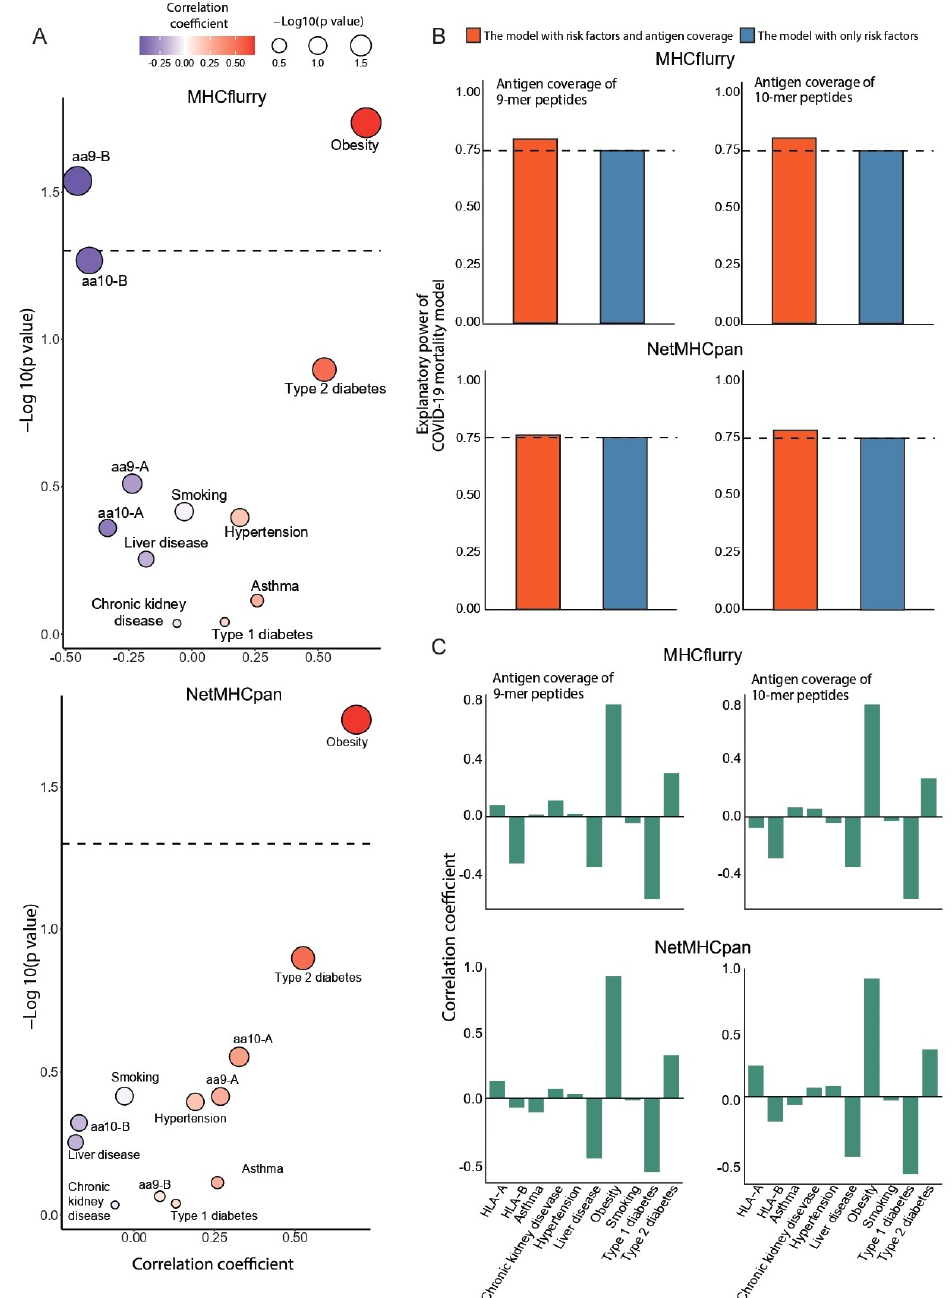
Figure 2. ( A ) Eight risk factors (asthma, chronic kidney disease, liver disease type 1 diabetes mellitus, type 2 diabetes mellitus, hypertension, obesity, smoking) and the antigen coverage of HLA-A and HLA-B were analyzed for their correlation with the death rate of COVID-19. The dot color and X -axis represent correlation coefficients, and the size and Y -axis represent p values. The dotted line indicates p value = 0.05. ( B ) The figure shows the r squared value of linear the regression model between mortality rate and risk factors. We compared the model constructed by risk factors (red bar) to the model extended by the antigen coverage of HLA-A and HLA-B (blue bar). We estimated antigen coverage by using 9-mer (left) and 10-mer peptides (right). The dotted line represents the r squared value of the regression model constructed using only risk factors. ( C ) The multivariate linear regression results for the mortality rates related to risk factors and antigen coverage, showing the coefficients of each risk factor and antigen coverage. We estimated antigen coverage by using 9-mer (left) and 10-mer peptides (right). The antigen coverage in Figure 2 was calculated based on the prediction of antigen presentation using MHCflurry and